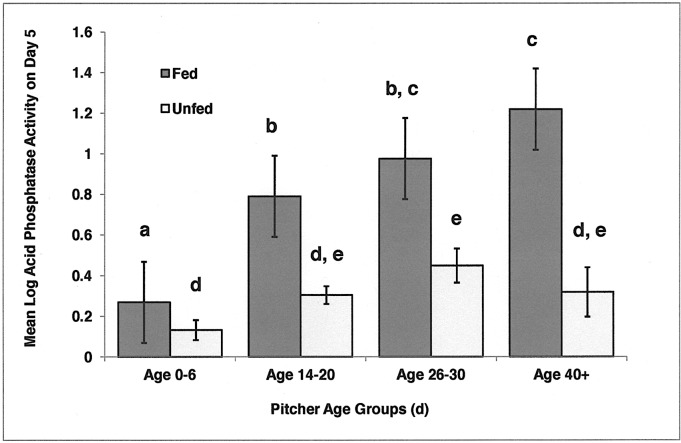
Means (± 1 SE) of the log of acid phosphatase activity measured on Day 5 (Log AcP(5)) for fed and unfed pitchers in four age groups.Fed pitchers exhibited a trend of increasing enzyme activity with pitcher age. Homogeneous subsets identified by Tukey HSD are labeled with the same letter. Sample sizes for Fed are: Age 0–6, n = 13, Age 14–20, n = 21, Age 26–30, n = 19, Age 40+, n = 3; and for Unfed are: Age 0–6, n = 14, Age 14–20, n = 14, Age 26–30, n = 14, Age 40+, n = 4.